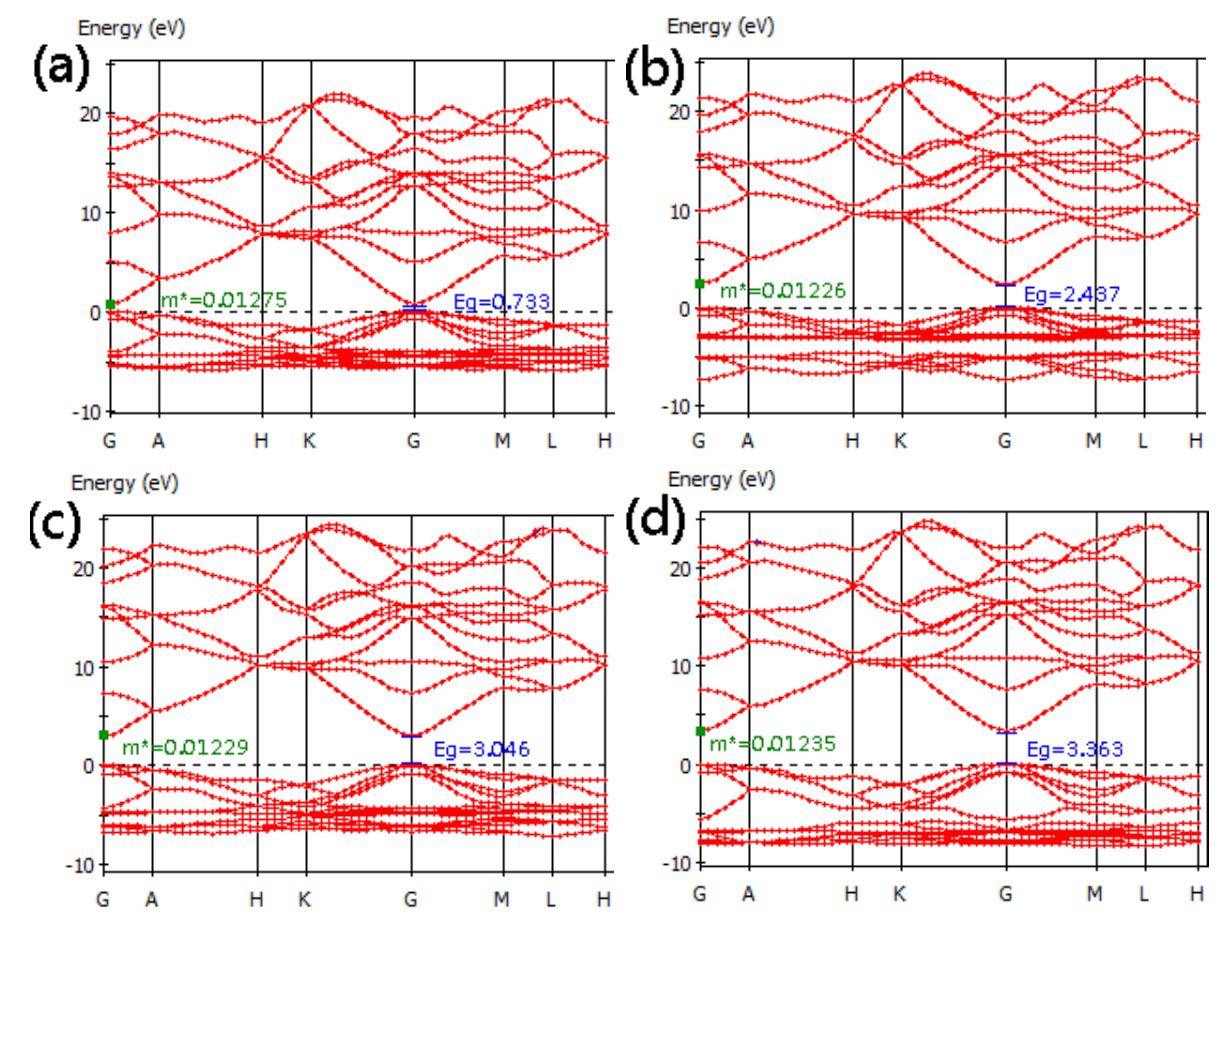
Figure 2. Band structure of ZnO primitive cell for cases